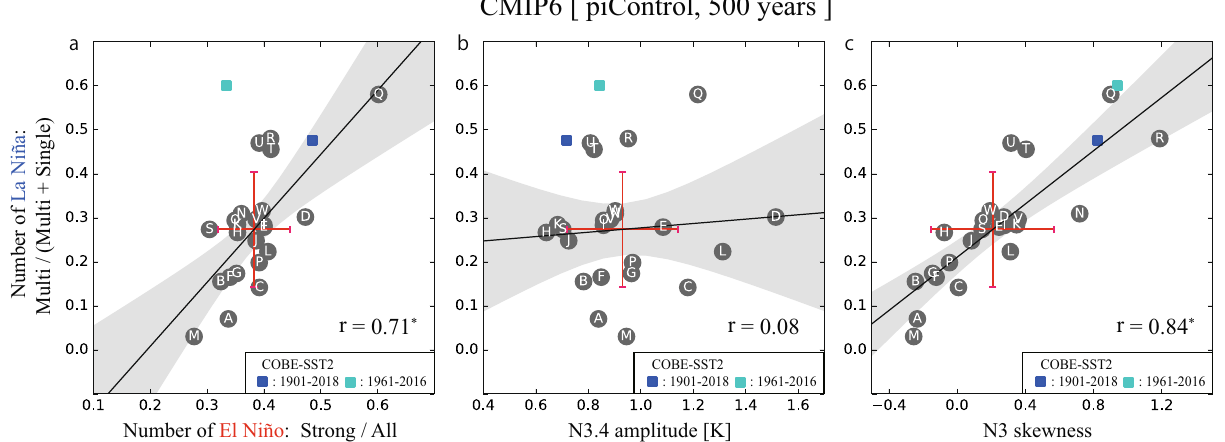
Figure 5. Relationship between the occurrence frequency of multi-year La Niña and the ENSO characteristics in CMIP6 pre-industrial control simulations. The vertical axis is a ratio of the number of multi-year La Niña against the total number of La Niña events. The horizontal axes are ( a ) a ratio of the number of strong El Niño against all El Niño events, ( b ) ENSO amplitude defined by one standard deviation of N3.4, and ( c ) ENSO amplitude asymmetry defined by skewness of the SST anomaly averaged in the Niño 3 region (90°–150° W, 5° S–5° N). Alphabetical labels indicate individual CMIP6 models shown in Supplementary Table S2, and blue dots show the observational references for two periods (1901–2018 and 1961–2016), The correlation coefficients among 23 models are shown at the bottom right and asterisks indicate statistically significant at the 95% confidence level. The red error bars denote one standard deviation range of the multi-model ensemble. The black line and grey shading represent the regression curve and its 95% confidence range,